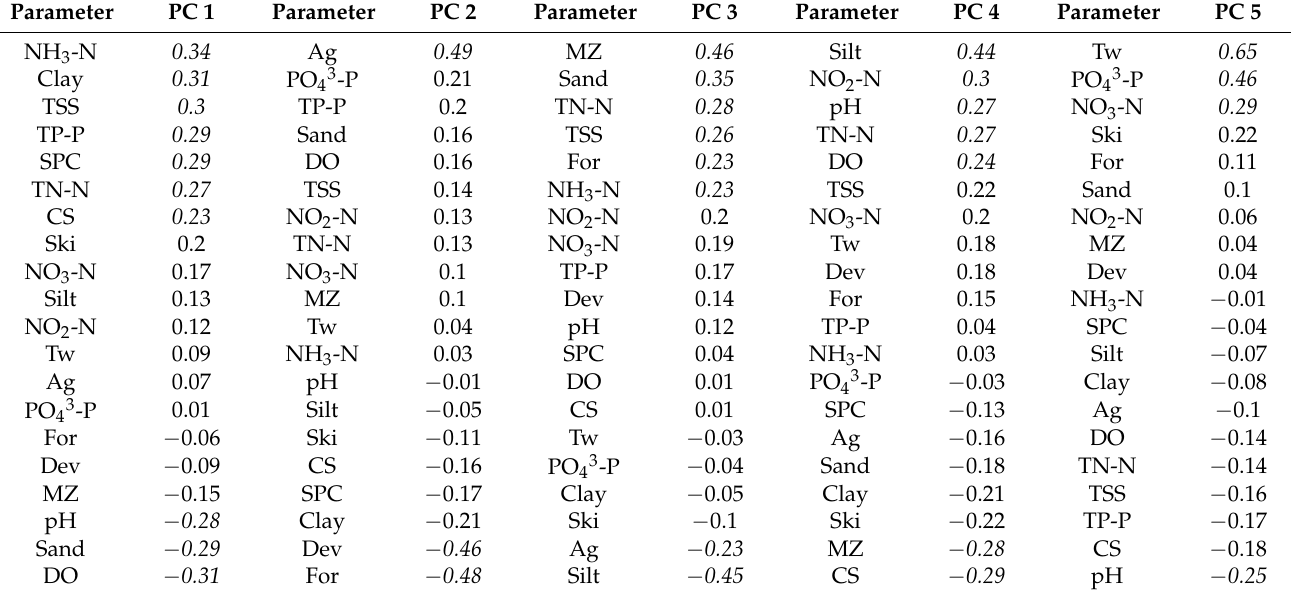
Table 4. PC Loadings for five principal components (PC) extracted from land use percent [Agriculture (Ag;%), Forest (For,%), and Developed (Dev,%)], nutrient concentrations (mg L − 1 ), suspended sedi- ment characteristics [total suspended solids; TSS (mg L − 1 ), mean particle size; MZ ( µ m), calculated surface area; CS (m 2 mL − 1 ), skewness; Ski, Sand (%), Silt (%), and Clay (%)], and